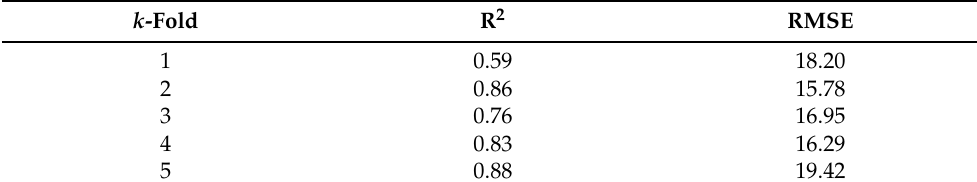
Table 6. ISWR k -fold cross-validation results.